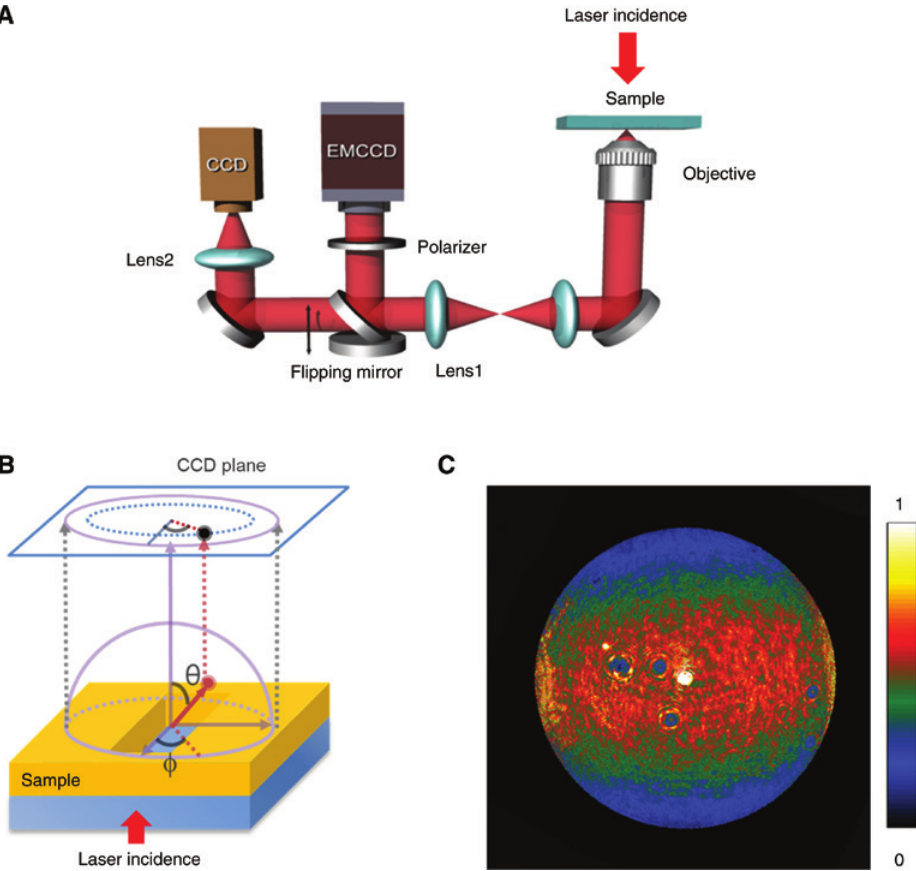
Figure 5: Fourier space measurement of far-field radiation from a metallic nanoslot. (A) Schematics of real and Fourier space image measurement set-up and (B) geometry of far-field radiation pattern and Fourier space image. The transmitted intensity of the red circle indicated by the red arrow and positioned at the coordinate qf( θ , φ ) on 3D hemisphere is projected at the position of black circle in the 2D CCD plane. (C) Measured Fourier space image of the far-field radiation from a metallic nanoslot. The intensity was normalized by the intensity of incident